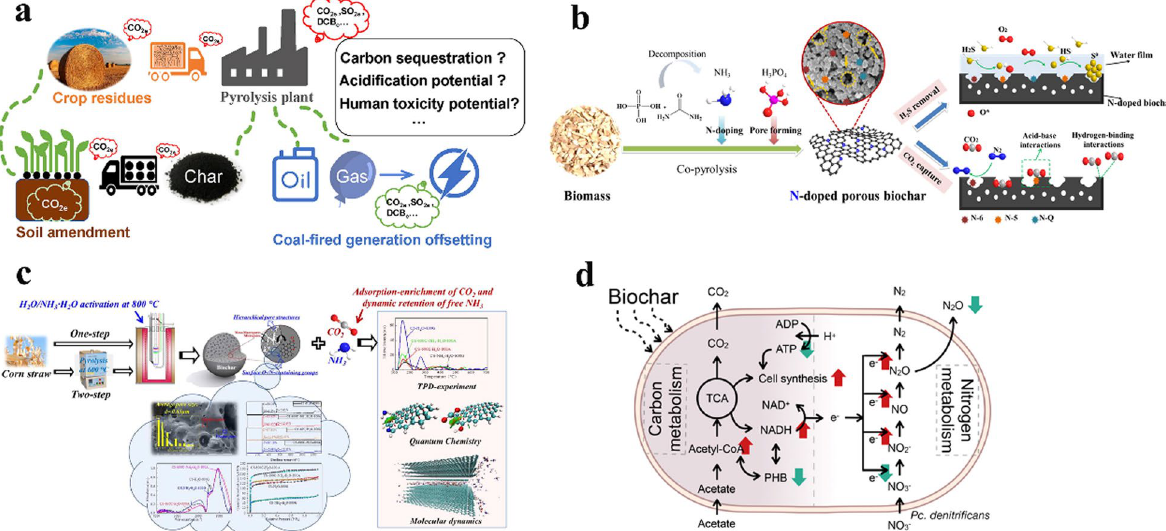
Fig. 5 Country-level potential of carbon sequestration for biochar implementation ( a ) (Yang et al. 2021d); The removal mechanisms of CO 2 by N-doped biochar ( b ) (Ma et al. 2021); The removal mechanisms of CO 2 by NH 3 mechanisms of N 2 O Emission by biochar at the cellular level ( d ) (Zhang et al. 2021